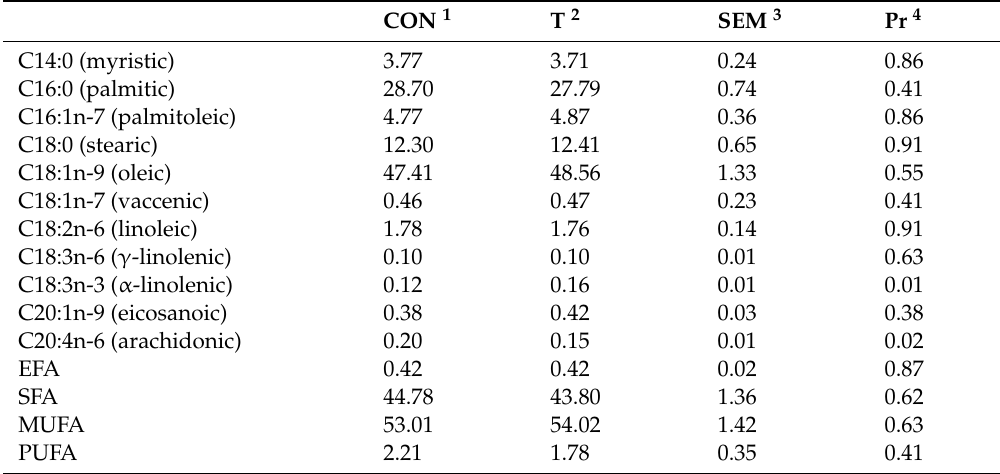
Table 6. Fatty acid composition in Hanwoo steer meat fed whole-crop barley silage (WCBS) / concentrate